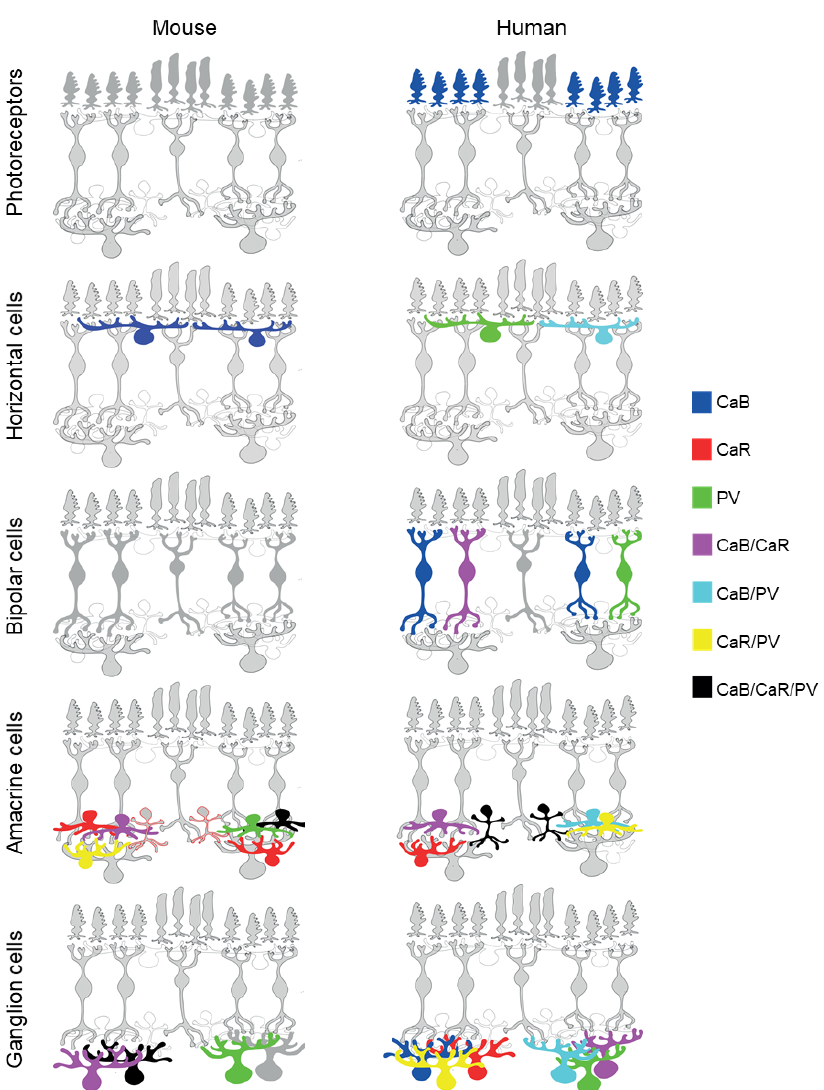
Figure 3. Parvalbumin (PV), calretinin (CaR) and calbindin (CaB) expression of mouse and human retinal neurons. Photoreceptors show little to no reactivity to the three examined CaBPs; in the PRL of the murine retina, no staining for CaB, CaR or PV has been demonstrated. At the same time, human cones (S, L / M) can all be labelled using CaB. CaB is expressed by HCs in both murine and human